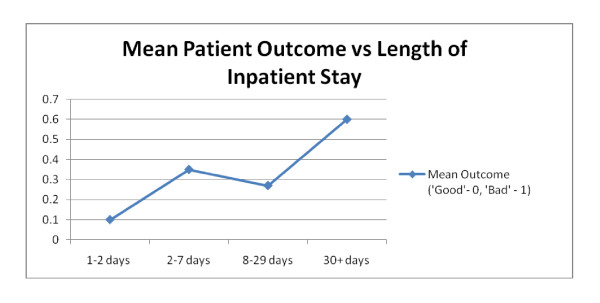
Patient outcome against Patient Variable (Length of In-patient stay).